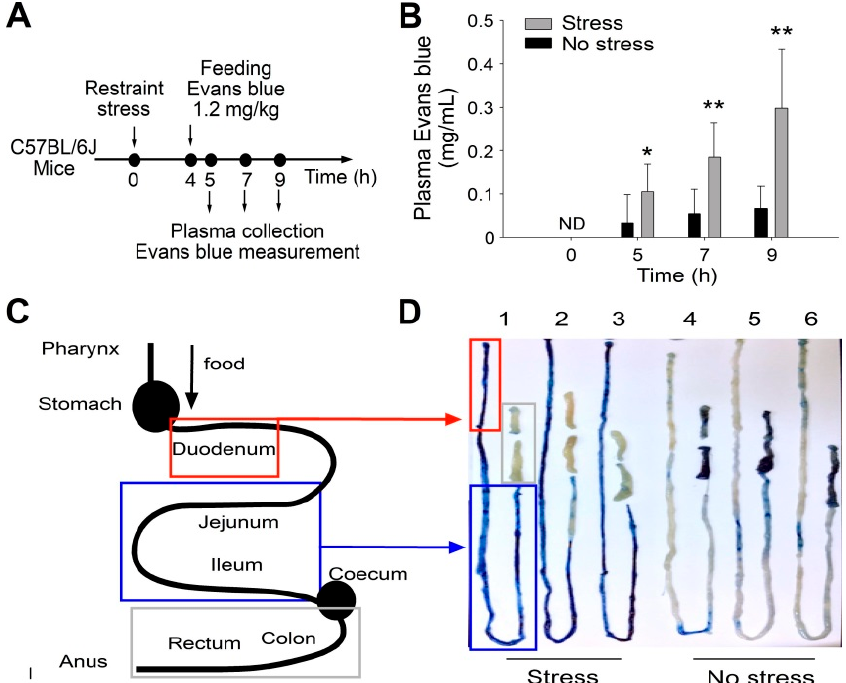
Figure 1. Restraint stress ‐ induced GI leakage is revealed by GI administration of Evans blue. ( A ) Experiment outline of the restraint stress mouse model with Evans blue treatments. ( B ) Plasma Evans blue levels of mice with or without restraint stress at 0, 5, 7, and 9 h. ND: not detected. Error bars show the standard deviation; * p < 0.05 and ** p < 0.01 vs. their respective no stress groups. ( C ) A schematic diagram of the mouse GI system according to the information provided by previous reports [59,60]. ( D ) Residue Evans blue in the mouse GI system after the experiment. The residue Evans blue primarily localized in the small intestine (duodenum and jejunum) region in the stressed groups. n = 9 (3 experiments with a total of 9 mice per group).